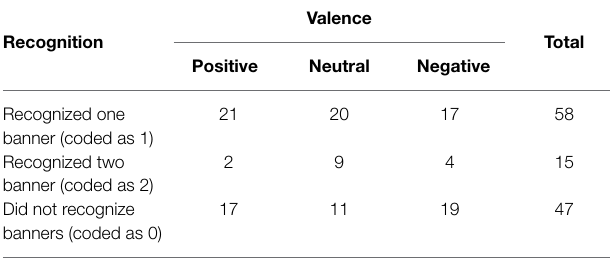
TABLE 9 | Summary table of recognized banners with positive, neutral, and negative valence.